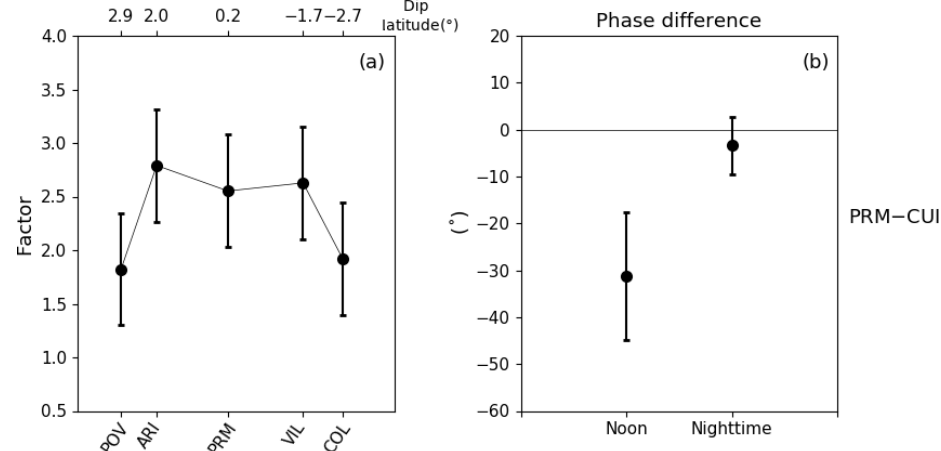
Figure 8. (a) Latitudinal profile of amplification factors for Pc5 pulsations around noon. (b) Phase delays between the dip equator station (PRM) and off-equatorial station (CUI) for Pc5 events during nighttime and around noon. Mean and standard deviations are indicated by dots and bars,